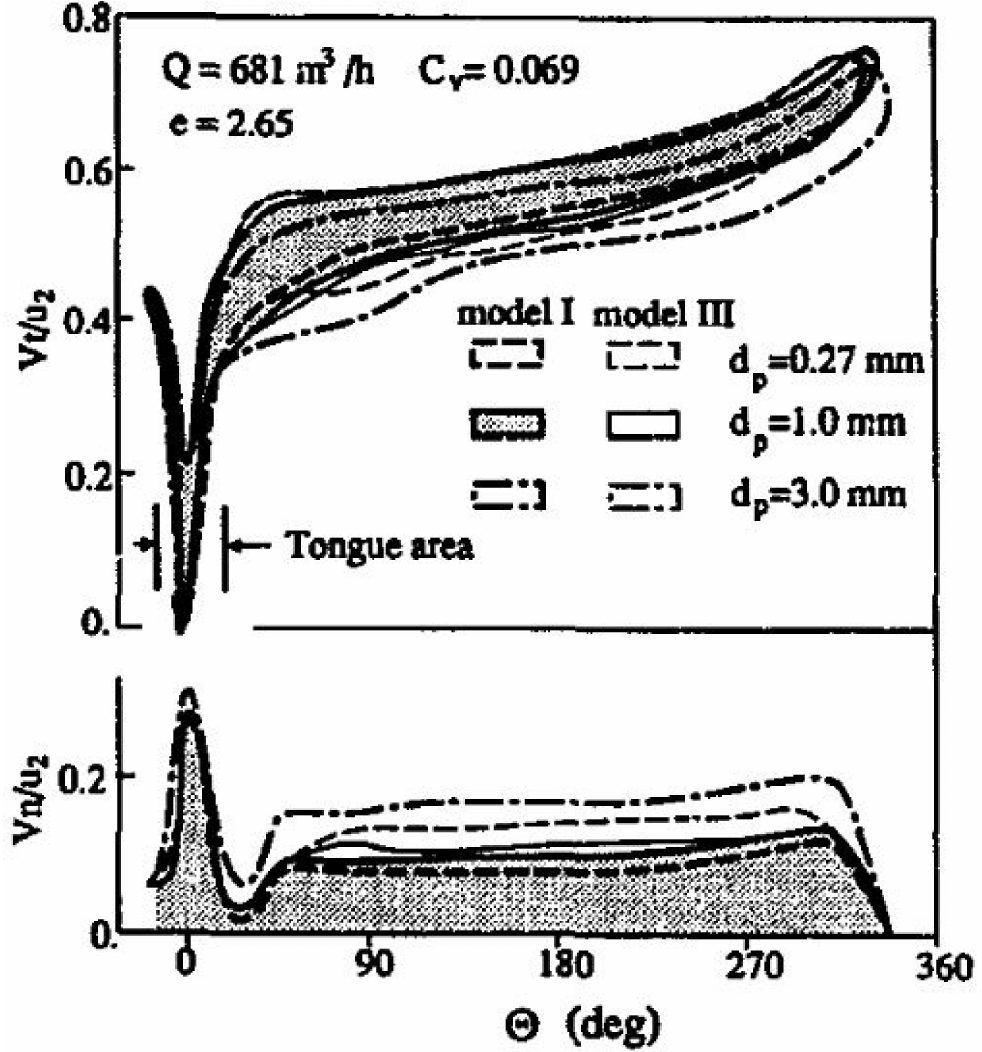
Figure 6. Impact velocity distribution as a function of angular position